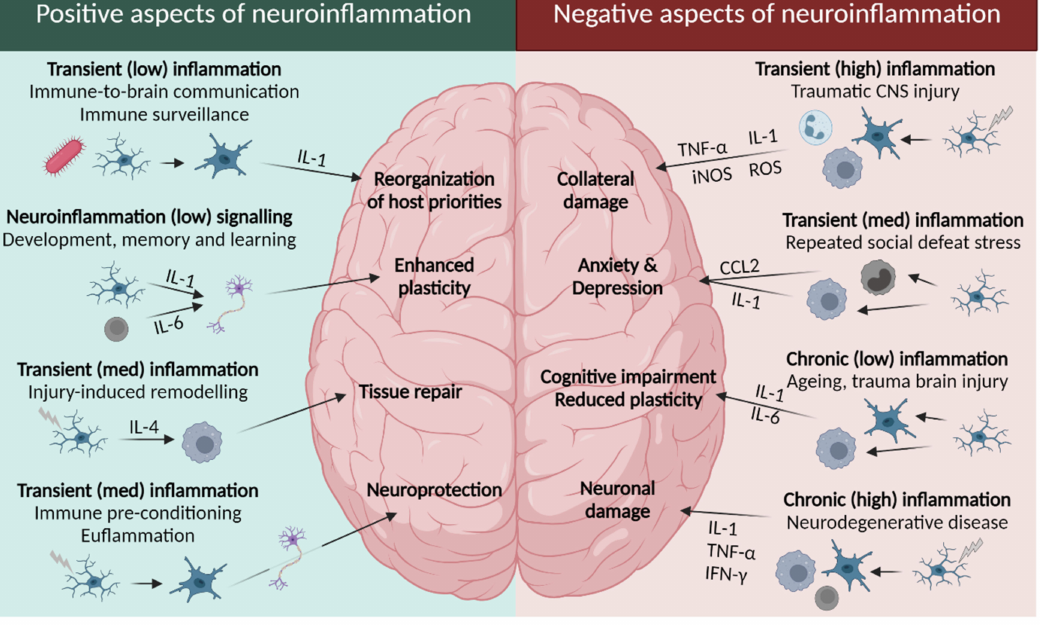
Figure 3. Positive and negative aspects of neuroinflammation . The consequences of neuroinflam- mation depend on the duration and severity of the immune response. ( Left ) induction of sickness behaviour to restore the host’s homeostasis after infection; ( right ) chronic neuroinflammation tends to carry negative consequences. Low, med, and high refer to a low, medium, and high levels of inflammation. Image adapted from DiSabato et al. [68], with permission from John Wiley and Sons. Created with